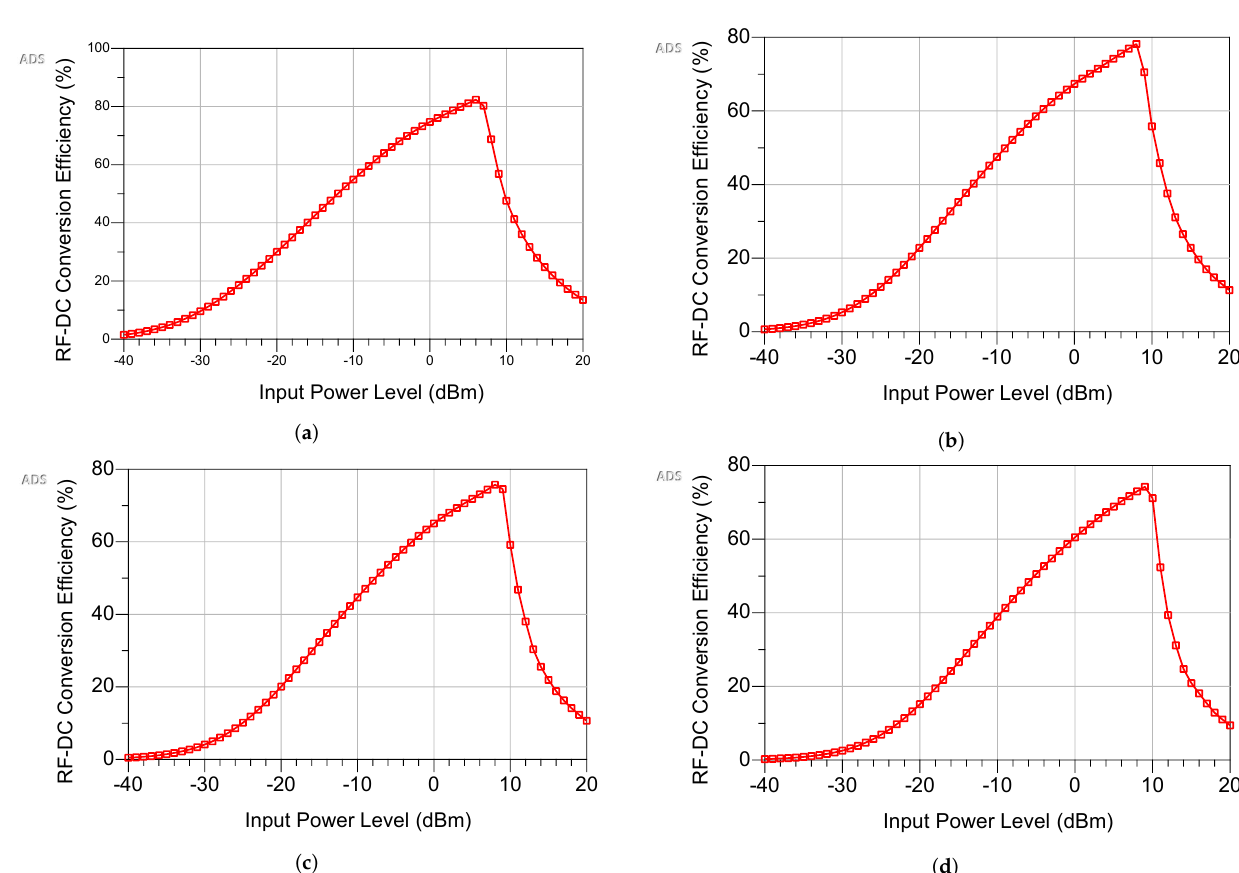
Figure 11. RF-DC conversion efficiency vs. the applied input power level at each single-band for the load of 5 k Ω . ( a )